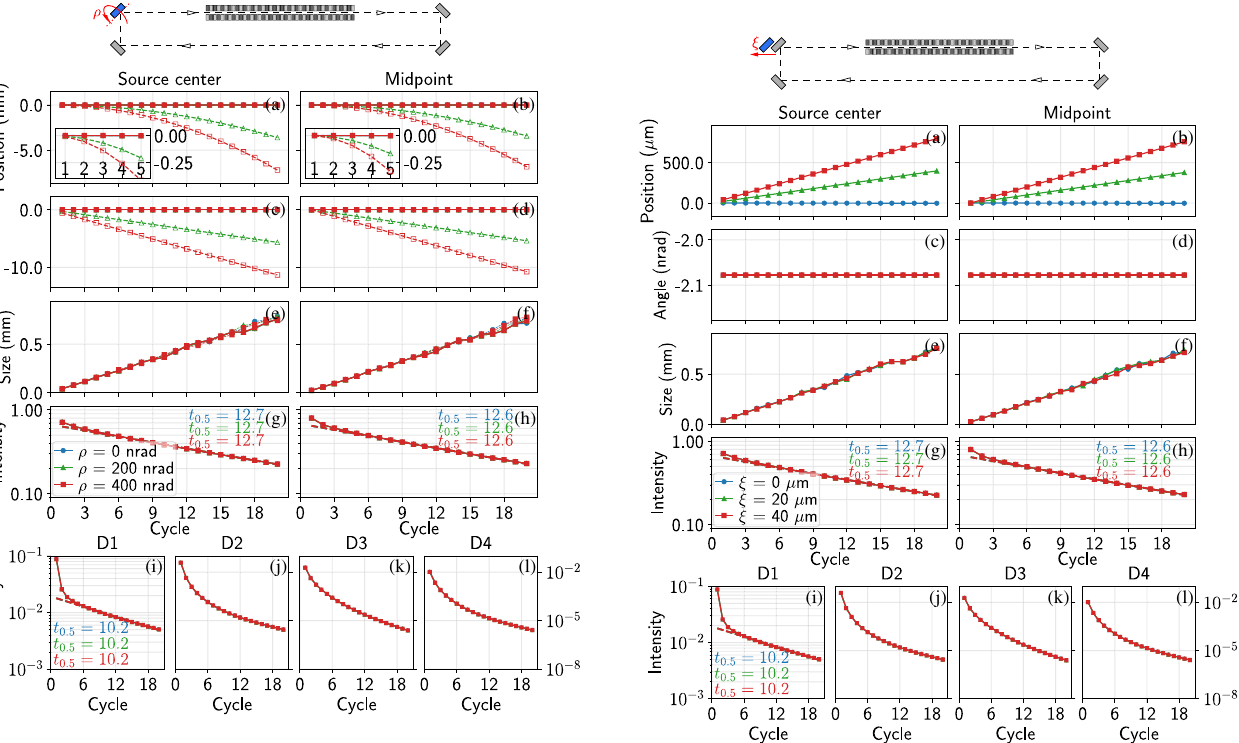
FIG. 11. Similar to Fig. 9, but with roll angle error ρ in crystal C 4 . The dashed lines show out-of-cavity-plane deflections. FIG. 12. Similar to Fig. 9, but with spatial error ξ in crystal C 4